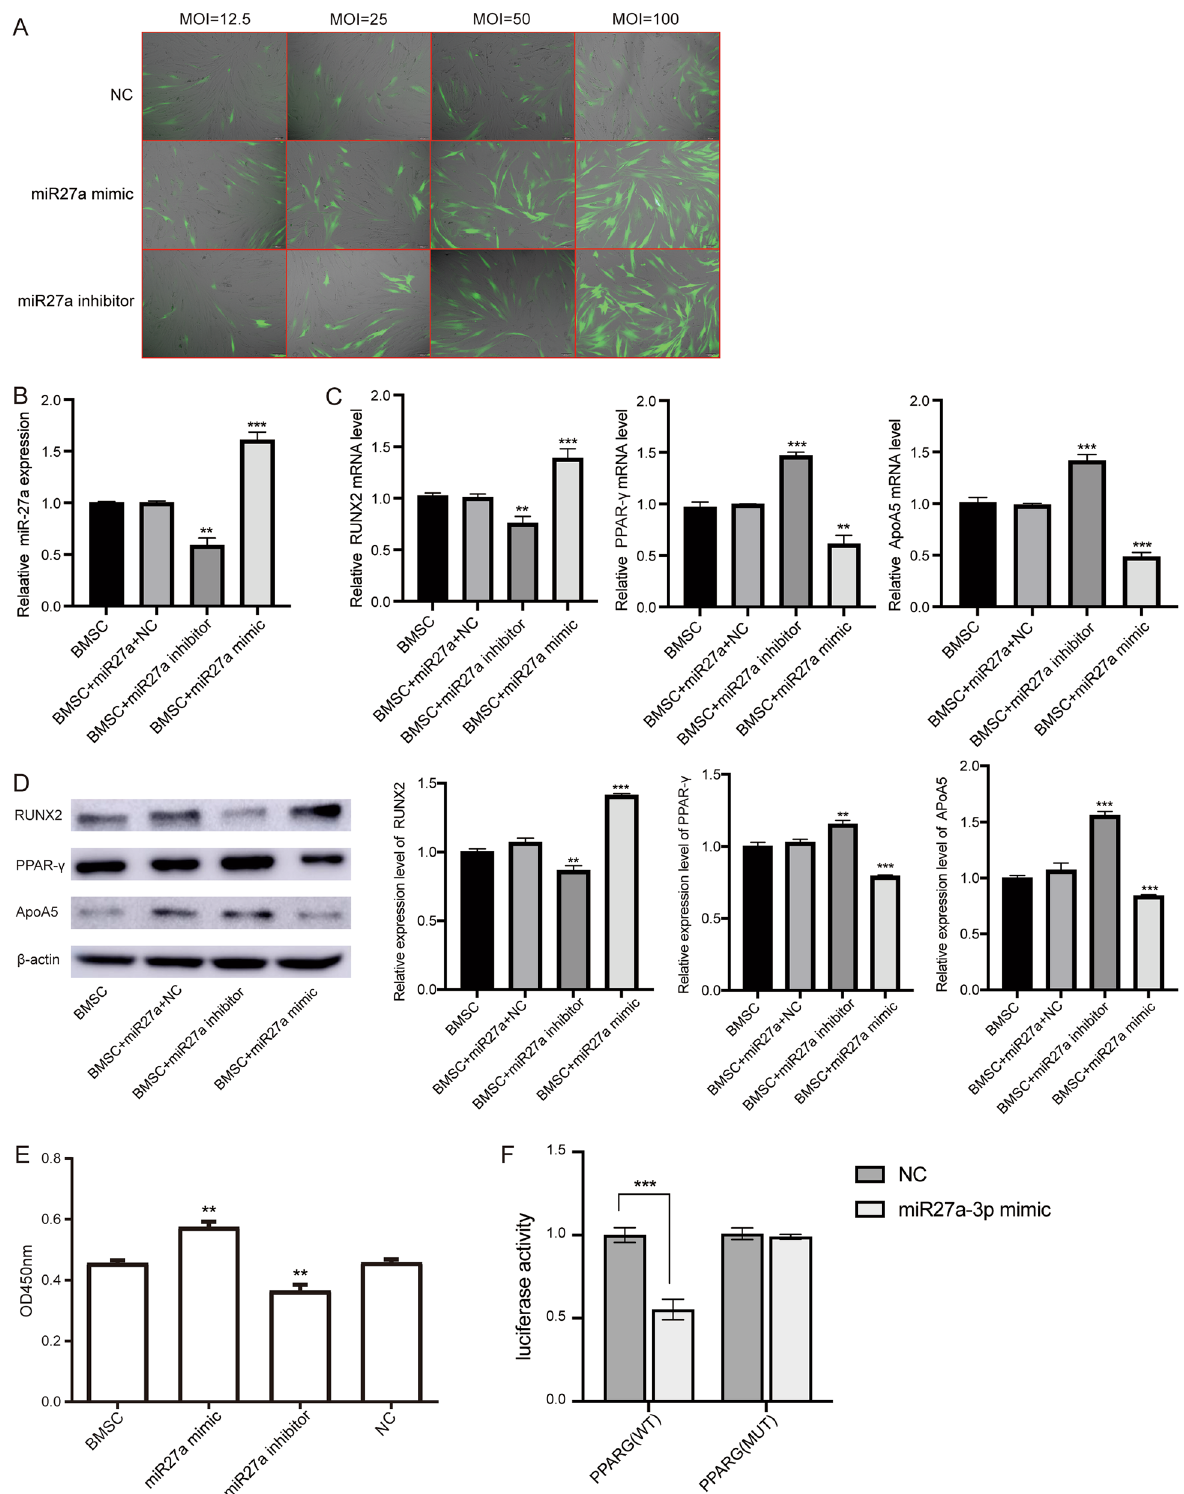
Figure 2. Overexpression of miR-27a promoted cell proliferation and changed expression of downstream genes. ( A ) Determination of optimal conditions for lentiviral transfection of BMSCs. ( B ) After transfection with miR-27a mimics, miR-27a inhibitor, and NC, the expression of miR-27a was detected by qRT ‐ PCR. ( C ) After transfection with miR-27a mimics, miR-27a inhibitor, and NC, the expression of Runx2, PPAR-γ and ApoA5 were detected by qRT ‐ PCR. ( D ) After transfection with miR-27a mimics, protein expression of Runx2, PPAR-γ and ApoA5 were detected by WB. ** P < 0.01, *** P < 0.001. ( E ) The cell proliferation of BMSCs with transfected miR-27a mimics, miR-27a inhibitor, and NC were assessed by CCK-8 assay. ( F ) Luciferase activity decreased following co-transfection with miR-27a-3p mimic and wild-type (WT) PPARG-3 ′ -UTR luciferase